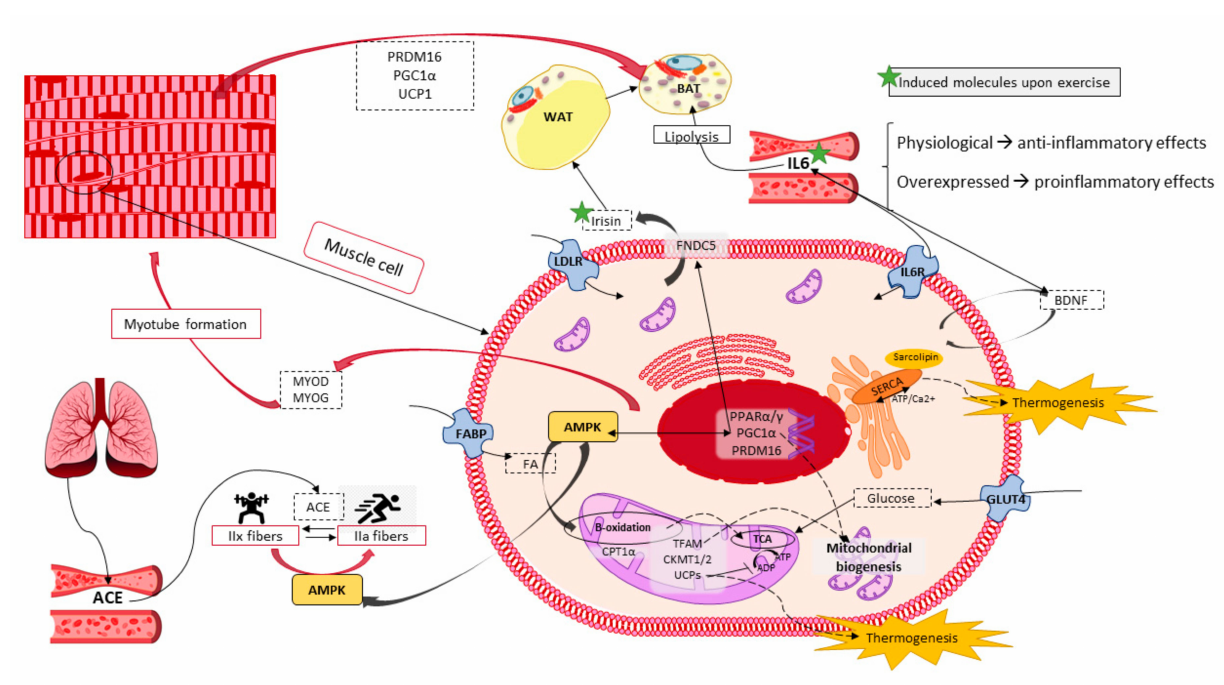
Figure 4. Skeletal muscle potential in energy balance through thermogenesis, and its influence on the browning and fiber-switch processes. Genes and proteins